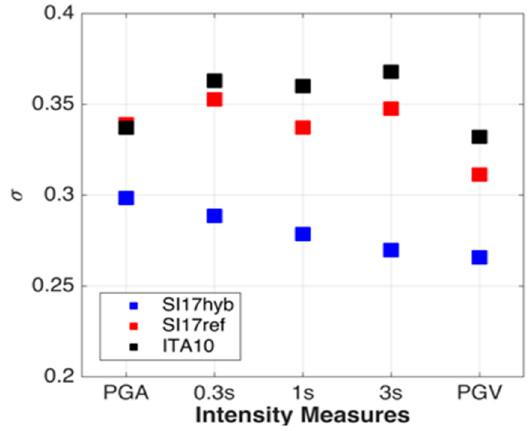
Figure 21. Total standard deviations ( σ ) of the hybrid (SI17hyb) and empirical (SI17ref) GMPEs for southern Italy. ITA10 [10] is the reference model for Italy.